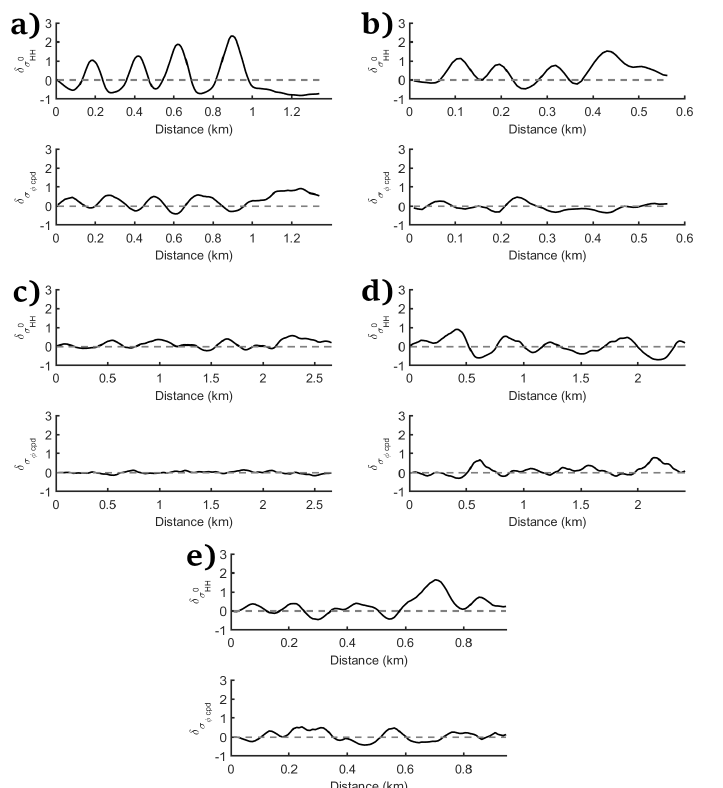
Figure 5. δ and δ σ profiles (upper and lower, respectively) associated to: ( a ) Image ID 1; ( b ) σ 0 HH φ CPD Image ID 4; ( c ) Image ID 6; ( d ) Image ID 7; and ( e ) Image ID 9 (Profile ID 9.1). The dotted green lines show the δ = 0; where l = l 0 .